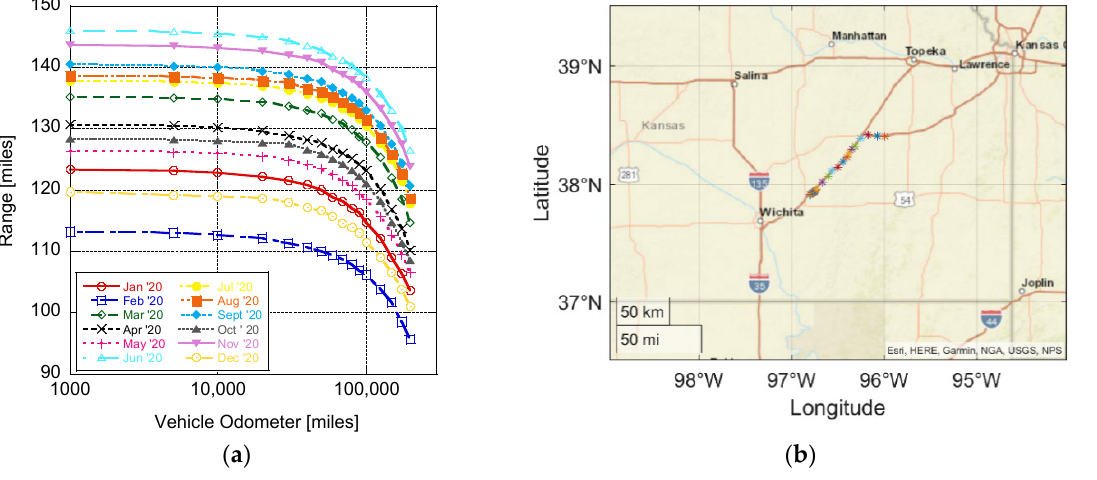
Figure 15. ( a ) Range of Jaguar I-Pace on I-35 N starting from the Oklahoma border as a function of the time of year and number of miles on the odometer with the HVAC system turned on. ( b ) The respective stopping points of the first leg indicated by symbols * as the vehicle ages using January 2020 as the month.